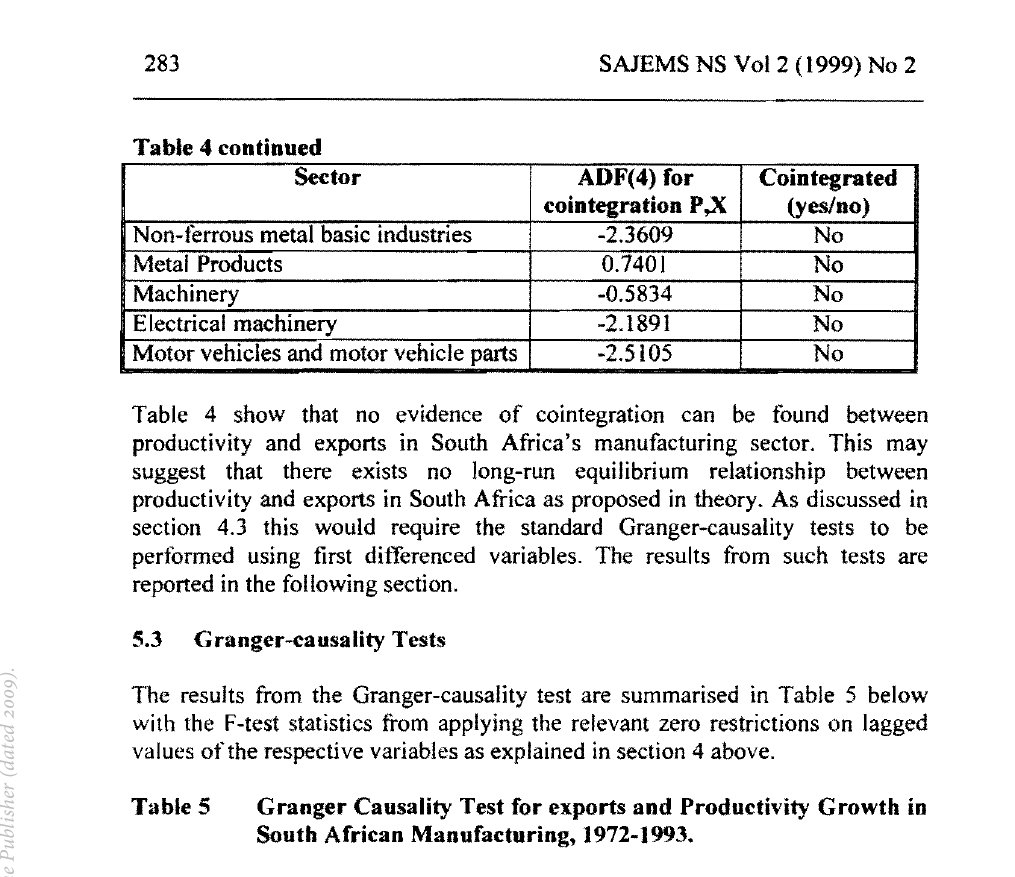
Granger Causality Test for exports and Productivity Growth in South African Manufacturing,